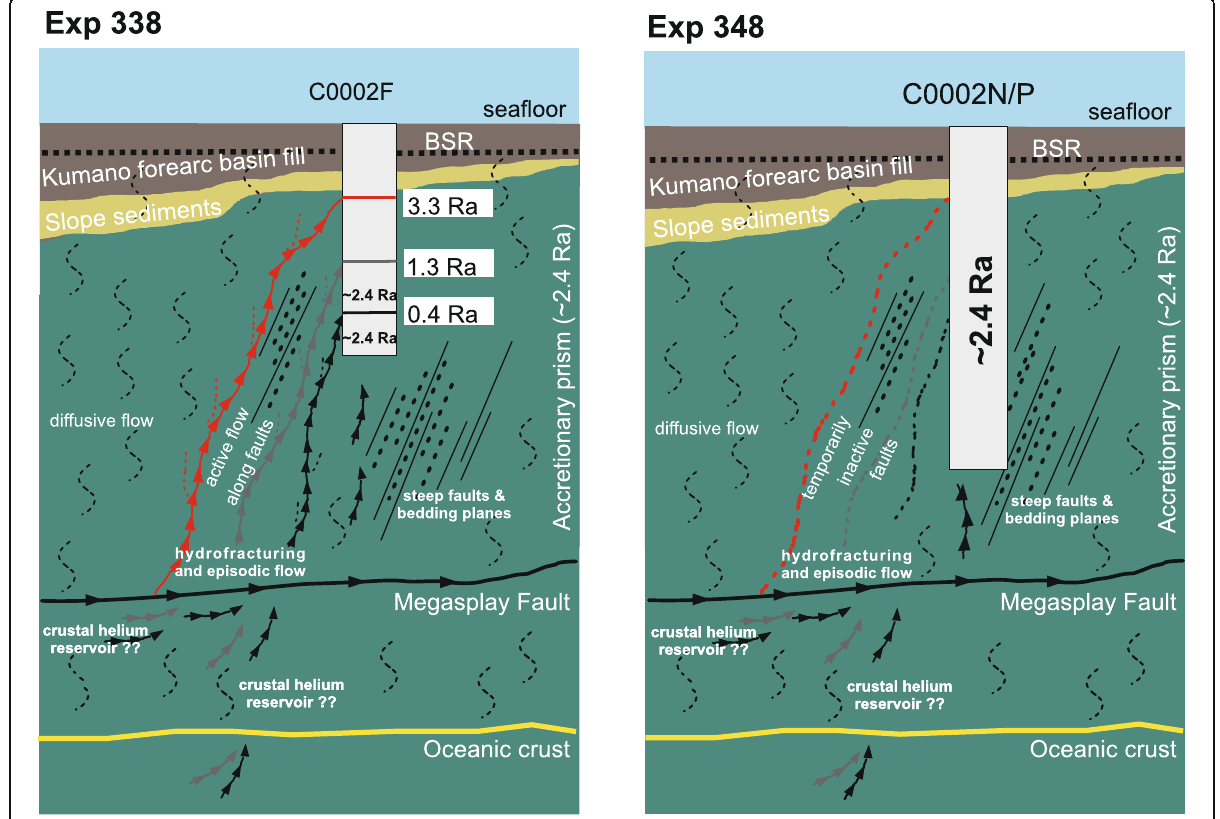
Fig. 5 Conceptual model of fluid flow in the accretionary prism of the Kumano forearc basin during Exp 338 (left diagram) and Exp 348 (right diagram), modified from Yamano et al. 1992 and Moore et al. 2015. While helium isotope and radon data would favour channelized fluid flow at several depths drilled during Exp 338 (red and gray solid lines) in addition to pervasive fluid migration through pore space, the 1 year later Exp 348 bears evidence only for pervasive fluid migration through pore space along mineral grain boundaries with an overall 3 He/ 4 He ratio of 2.4 Ra (dashed curved